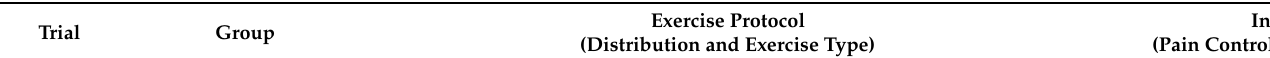
Frequency and Duration